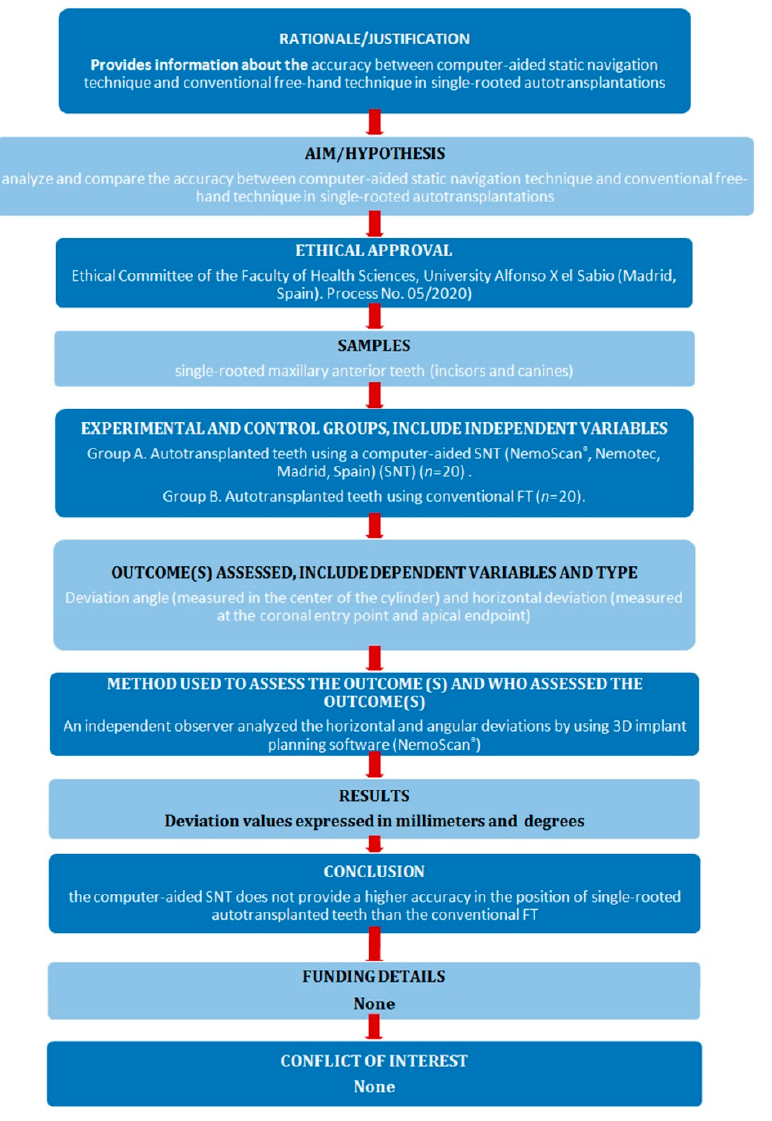
Figure 1. Preferred reporting items for laboratory studies in endodontology flowchart.